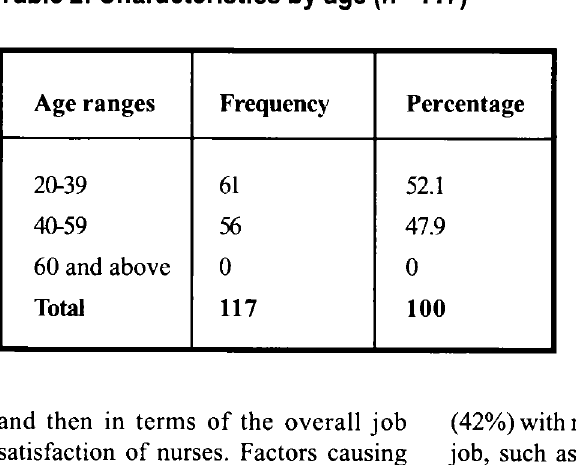
Table 2: Characteristics by age (n= 117)